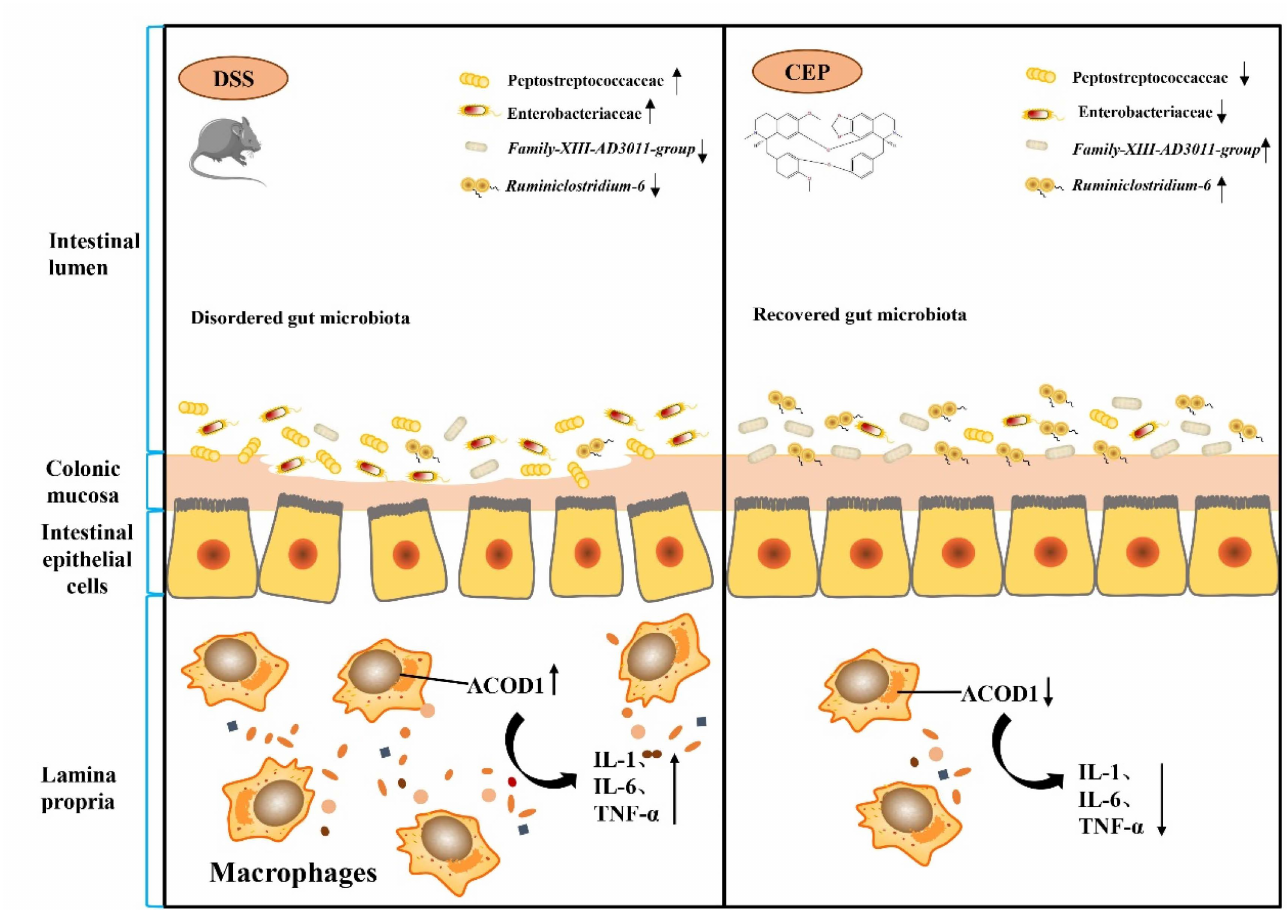
Figure 6. Illustration of the molecular mechanisms underlying the positive effect of CEP on exper- iment colitis. Cepharanthine restores the dysregulated gut microbiota to affect the macrophages infiltration and ACOD1 expression to improve the inflammation of colon tissue in colitis